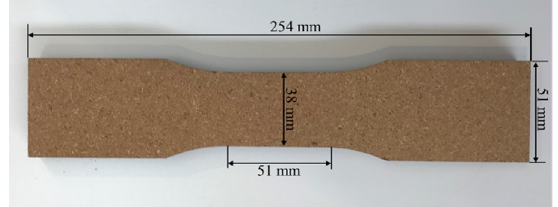
Figure 1. Specimen for determination of tensile strength parallel to surface.